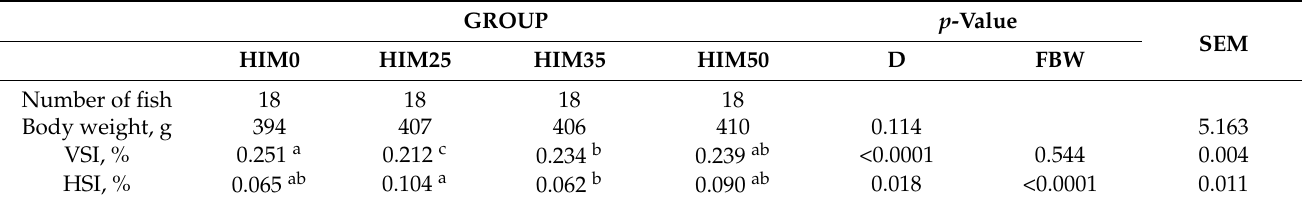
Table 3. Somatic indices of gilthead seabream fed the experimental